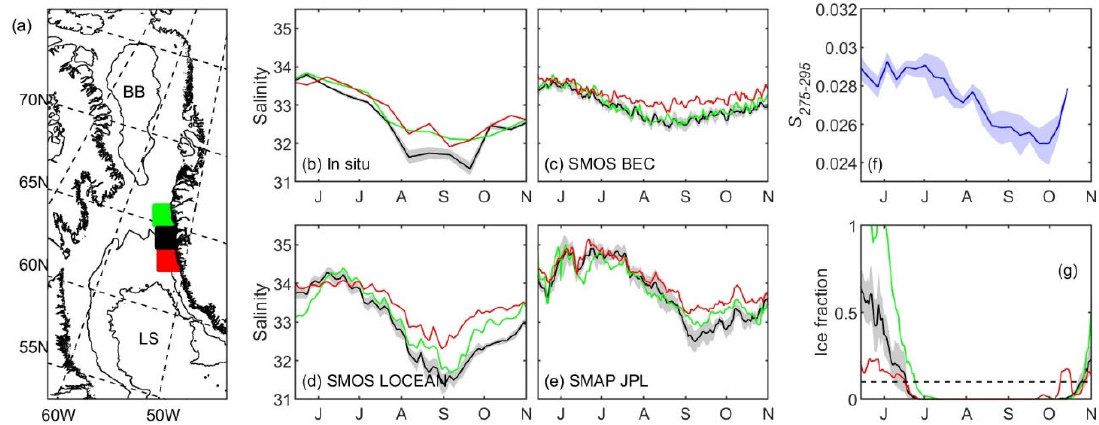
Figure 7. ( a ) Study area indicating northern (green), central (black), and southern (red) locations. For each location, surface salinity observations were spatially averaged and plotted as time series based on ( b ) in situ data, ( c ) SMOS BEC, ( d ) SMOS LOCEAN, and ( e ) SMAP JPL. Shaded gray around time series for central area (black) shows the standard error of the mean. ( f ) Time series of CDOM spectral slope coefficient S 275–295 (nm − 1 ), spatially averaged over the southern, central, and northern region. The three subregions were combined to increase the number of available observations, given that MODIS is affected by cloud cover. ( g ) Time series of ice fraction (%) for the three subregions. The dashed line shows ice fraction of 0.1%.